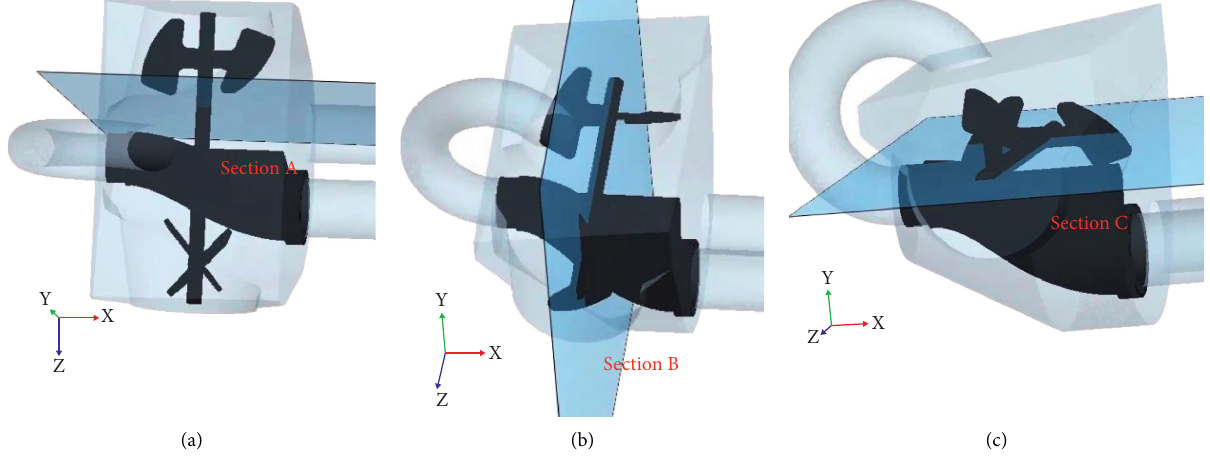
Figure 12: The position of